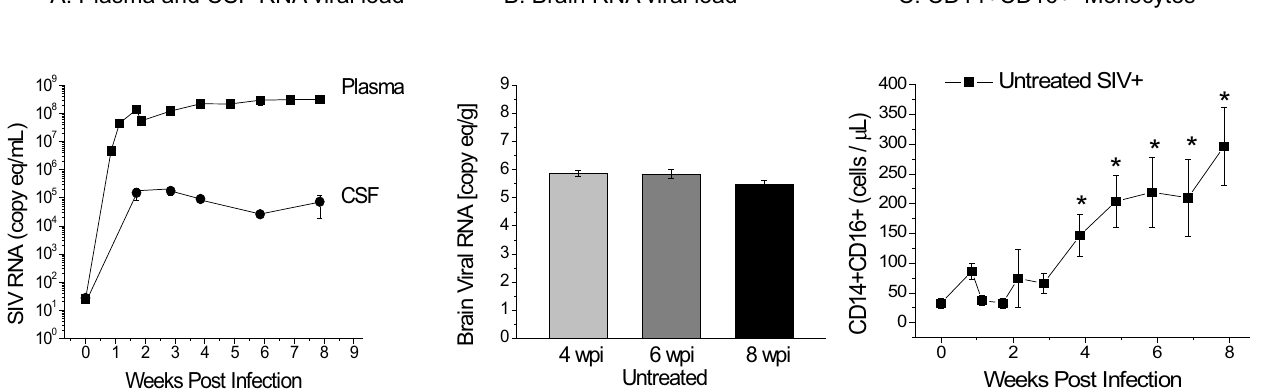
Fig 1. Viral RNA plateaus w/o treatment. A. Viral RNA was detectable in plasma 6 days after infection (~10 7 copies eq./mL) and the viral load approaches a plateau by 4 weeks after infection. The mean plasma viral load was 4.9 x 10 8 copies eq./mL at 8 wpi. Cerebrospinal fluid viral loads were found to be approximately 3 orders of magnitude lower than plasma. B. The amount of viral RNA in the frontal cortex of untreated animals was 7.5 x 10 5 , 9.2 x 10 5 and 3.0 x 10 5 copies eq./g at 4, 6, and 8 weeks after infection, respectively, and was not significant (P > 0.11) and had a mean of ~ 10 6 copies eq./g. C. SIV+ animals had high levels of circulating CD14 + /CD16 + monocytes 28 days after infection, and they had ~300 cells/ μ L by 8 weeks. ( (cid:3) indicates significant differences from